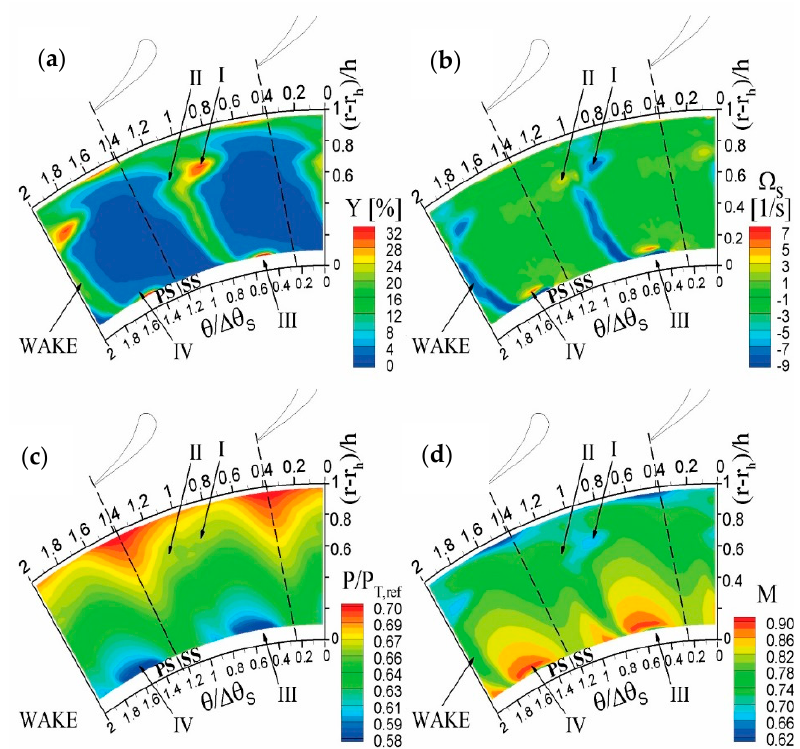
Figure 3. Stator-exit flow field in OP1, ( a ) total pressure loss coefficient; ( b ) streamwise vorticity; ( c ) local expansion ratio; ( d ) absolute Mach number.